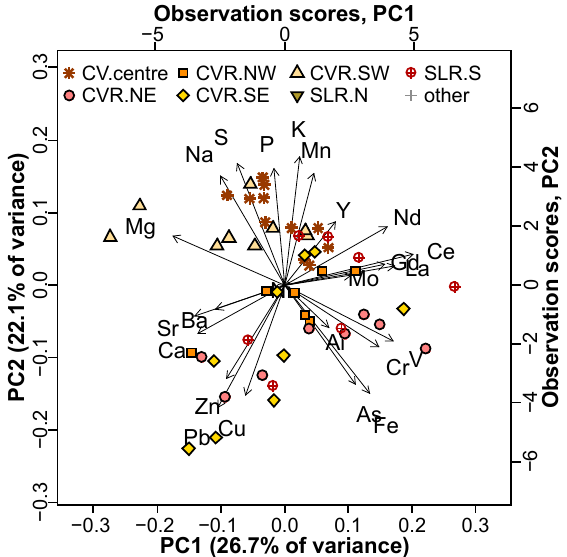
Figure 7. Principal components biplot for the first two principal components based on elemental composition in surface soil at Charles Veryard and Smith’s Lake Reserves. Observation scores are identified by sampling Zone (see Figure 2). Concentrations were transformed using centered log-ratios before PCA, to avoid spurious effects of compositional closure.